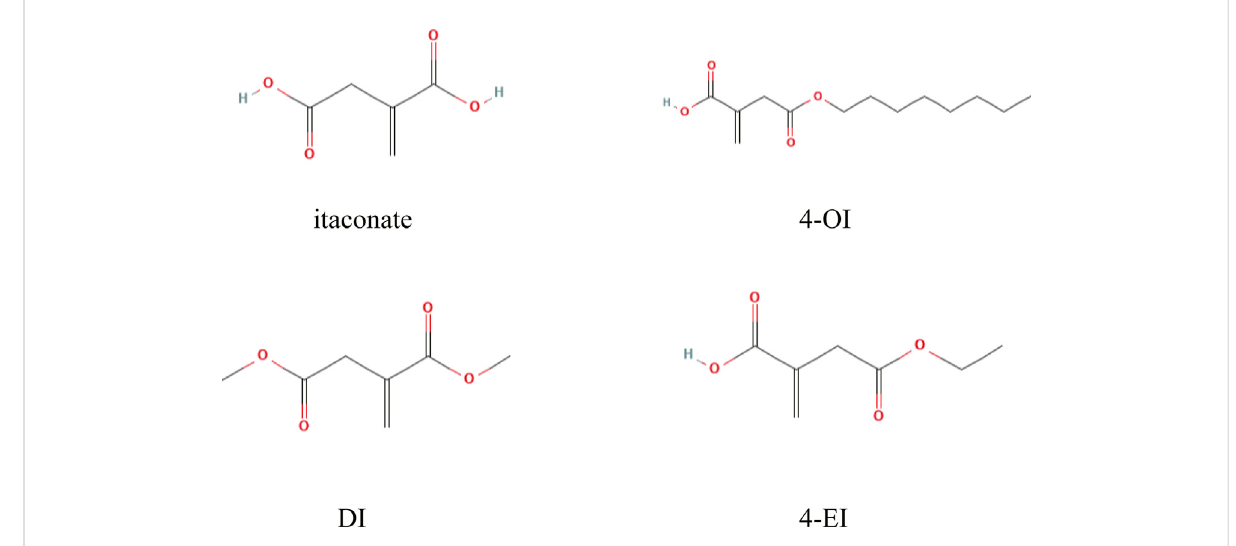
FIGURE 2 Chemical structures of itaconate and its derivatives.